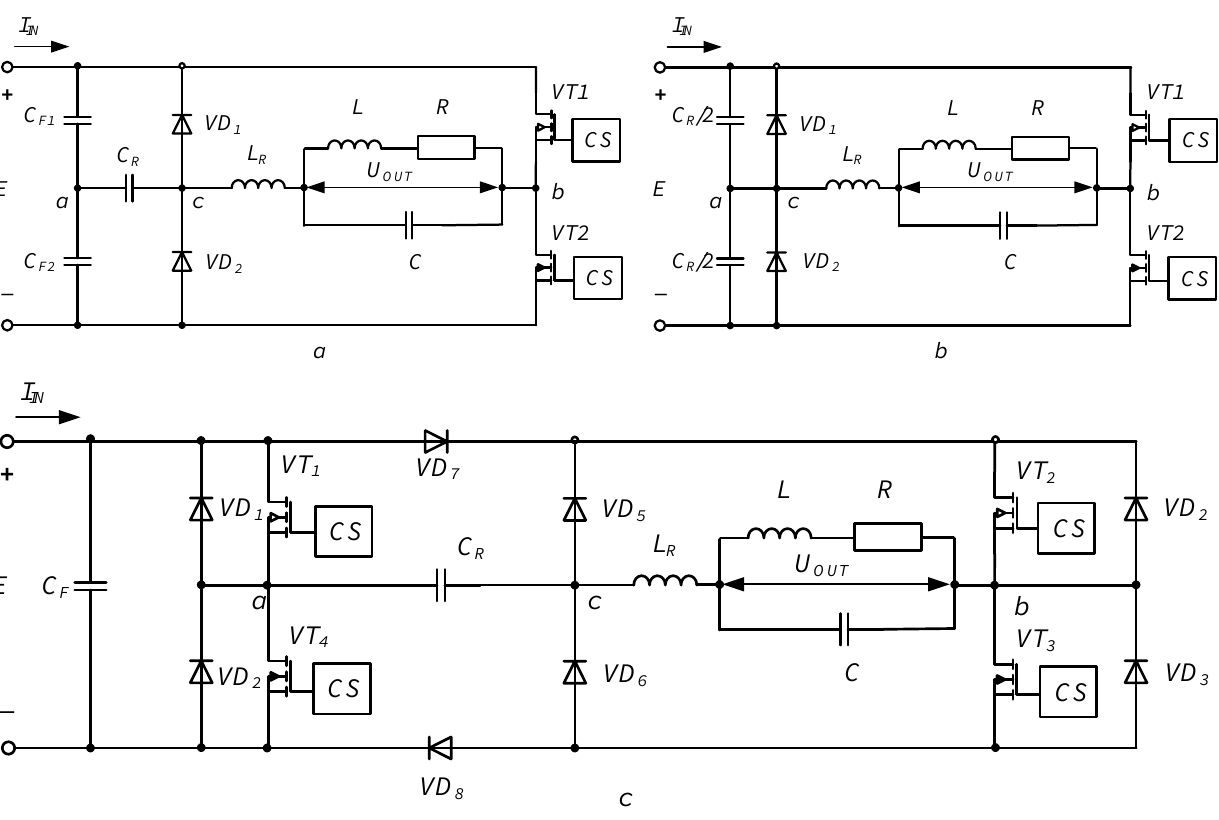
Figure 1. Schematic variants of RI with ED ( a ) half-bridge circuit; ( b ) with split resonant capacitor; ( c ) full-bridge